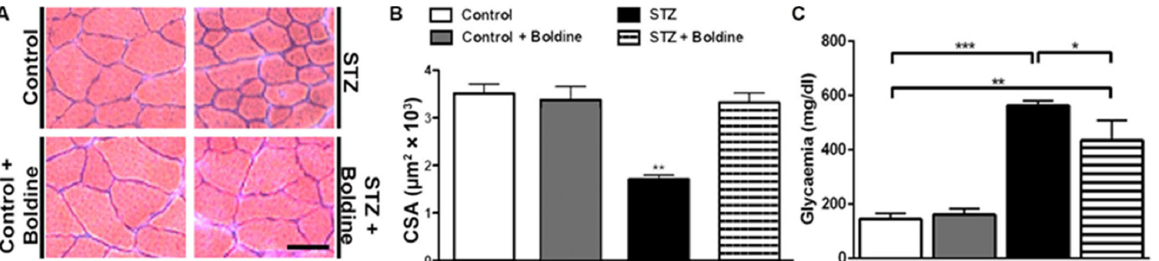
Figure 1. Boldine prevents the reduction in cross-sectional area of skeletal myo fi bers and partially prevents the elevated glycaemia in diabetic rats. ( A ) Representative hematoxylin–eosin-stained preparations of TA muscles from control and diabetic (STZ) rats treated or not with boldine. ( B ) Quanti fi cations of images such as those shown in A ( around 100 myo fi bers per animal were ana- lyzed). Muscles of control (white bar), control treated with boldine (grey bar), diabetic (STZ, black bar), and diabetic treated with boldine (STZ + Boldine; 50 mg/kg, dashed bar) animals were pro- cessed for hematoxylin–eosin staining. The CSA was measured by o ffl ine analysis with ImageJ soft- ware. ( C ) Glycaemia levels were analyzed from tail blood of control and STZ rats treated or not with boldine. *** p < 0.001; ** p < 0.01; and * p < 0.05. Scale bar: 50 µm. (N = 5 animals per group, 10 images were taken per animal and were analyzed (around 500 fi bers per group )).